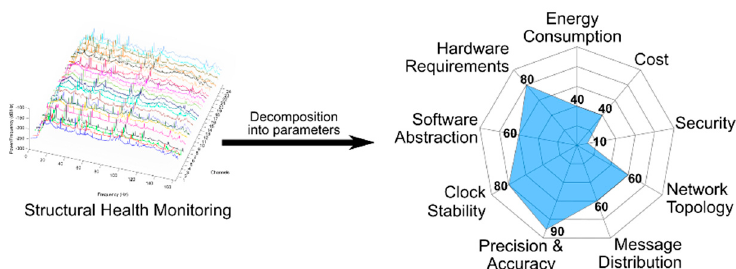
Figure 7. Radar chart generated based on the input form for a specific structural health monitoring application. Since the area of the chart is big, it represents that the application is very demanding in the considered parameters.